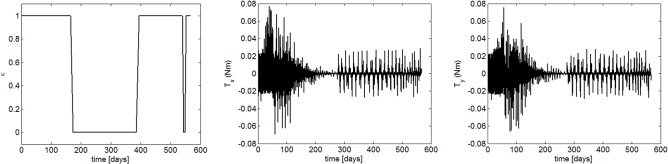
Control histories.